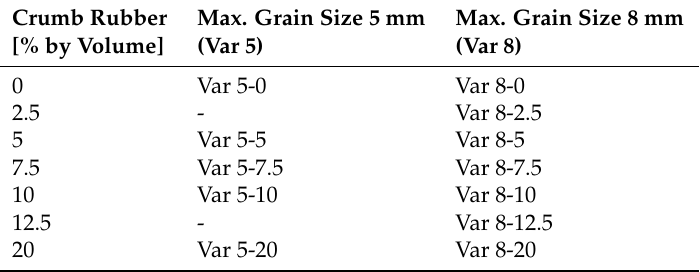
Table 1. Tested variants.